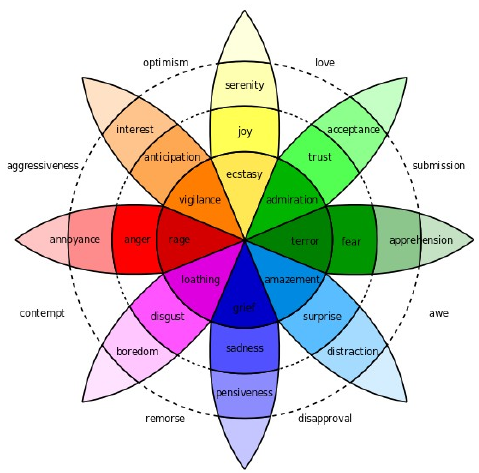
Figure 1. Plutchik wheel of emotion